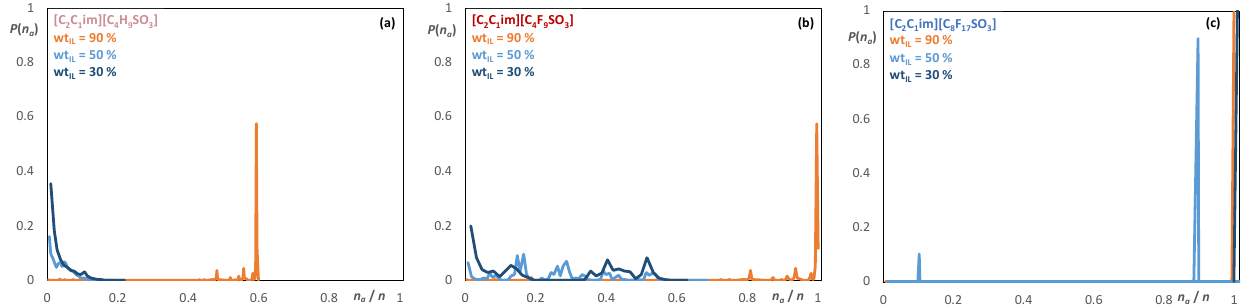
Figure 10. Discrete probability distribution of nonpolar aggregates for ( a ) [C 2 C 1 im][C 4 H 9 SO 3 ], ( b ) [C 2 C 1 im][C 4 F 9 SO 3 ], and ( c ) [C 2 C 1 im][C 8 F 17 SO 3 ]. Data for aqueous solutions with wt IL = 30 % (X IL = 0.01–0.04), wt IL = 50 % (X IL = 0.05–0.10), and wt IL = 90 % (X IL = 0.23–0.49).